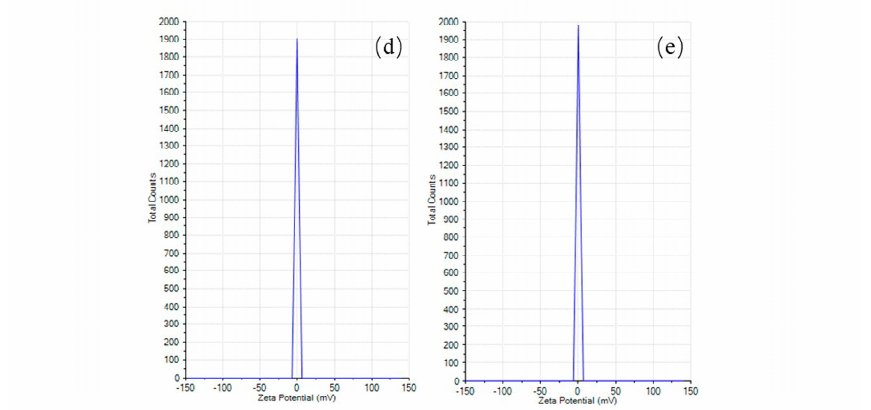
Figure 5. Zeta potential measurement for synthesized PCL particles: ( a ) 2 wt% 100% CF, ( b ) 2 wt% 1:1 AA/CF, ( c ) 2 wt% 3:1 AA/CF, ( d ) 2 wt% 100% AA, and ( e ) 4 wt% 100% AA.